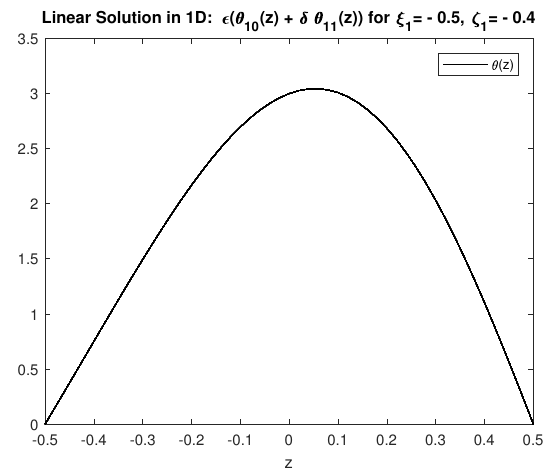
Figure 8. Linear 1D solution for W , i.e., (cid:101) ( W 10 ( z ) + δ W 11 ( z )) .